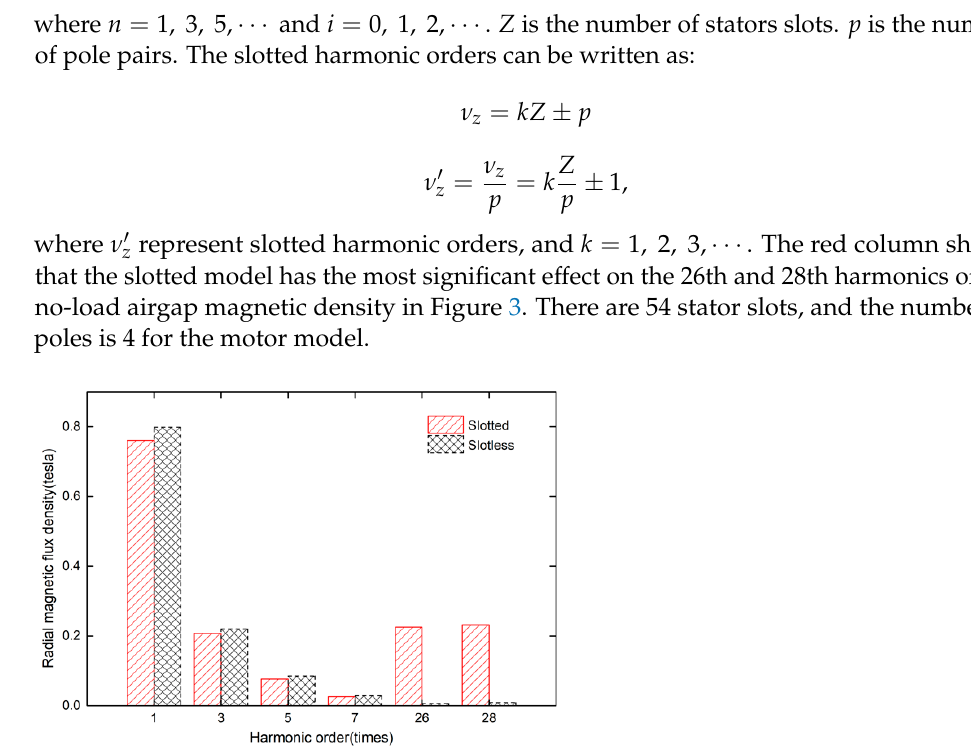
Figure 3. Harmonic spectra of the radial component of the airgap flux density at no − load. The presence of slots affects the radial airgap flux density waveform and distorts the tangential flux density. Figure 4 shows in the harmonic order for the tangential density component at no-load. The slotted harmonics mainly affect the 26th and 28th harmonics of the tangential magnetic density. For the slotted motor, the 26th and 28th harmonics increase by 2195% and 2218% for the radial airgap magnetic density, respectively, and by 3157% and 4236% for the tangential airgap magnetic density, respectively, compared with the slotless motor.